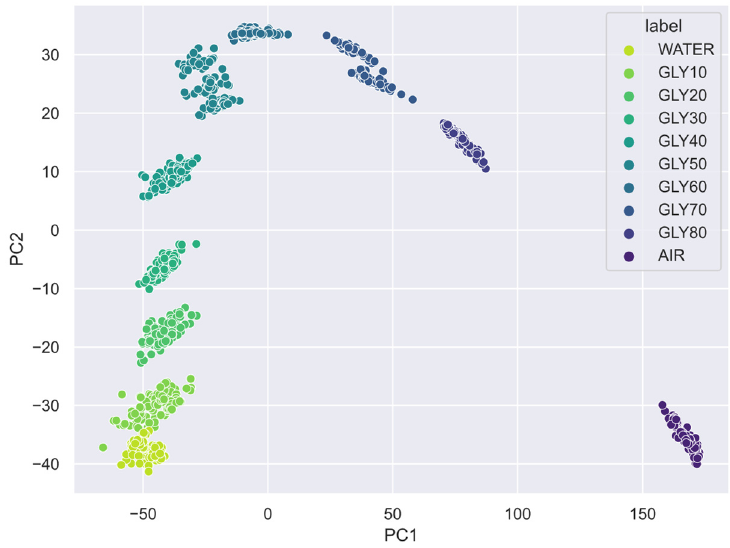
Figure 9. PCA sca tt er plot of the VNA spectra. Figure 9. PCA scatter plot of the VNA